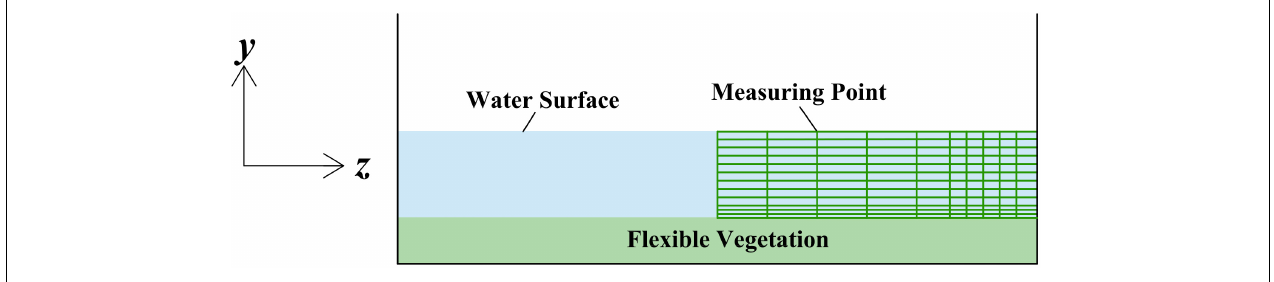
FIGURE 3 | Open channel mesh